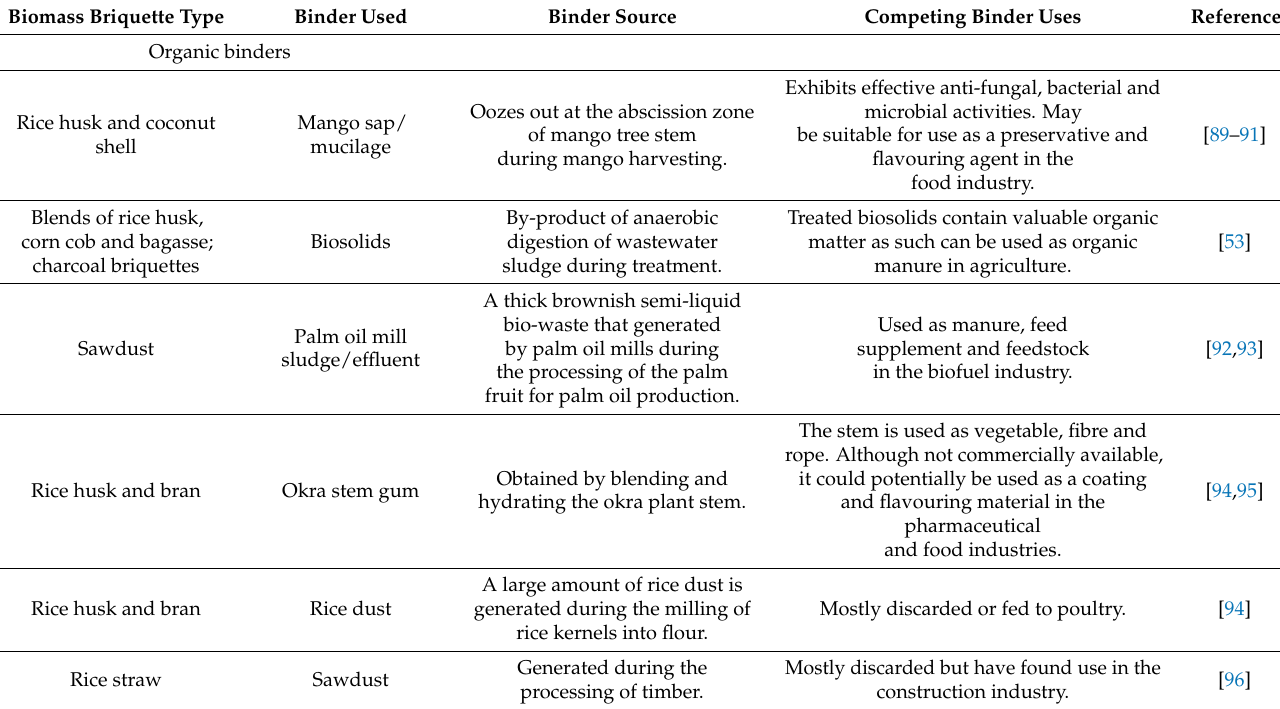
Table 3. Binders used in biomass briquette